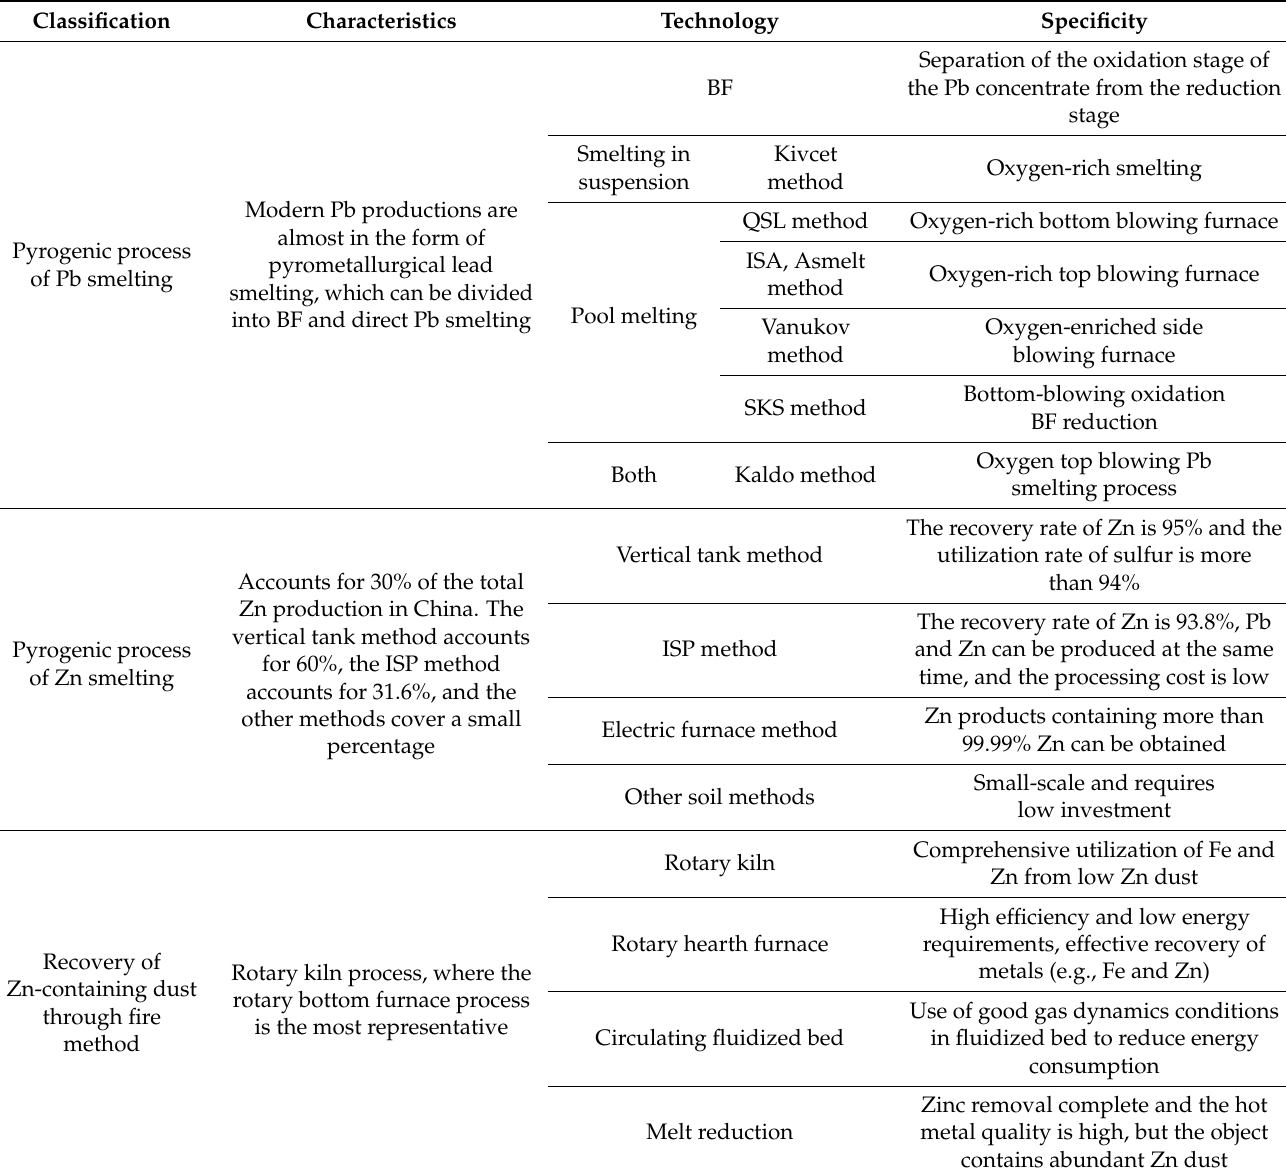
Table 3. Technical characteristics of the Pb–Zn metallurgical reduction process. Classification